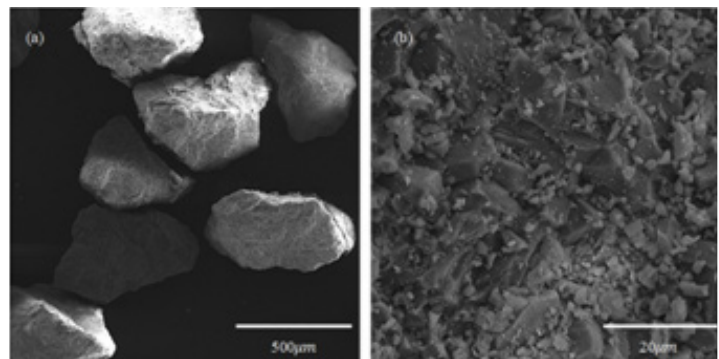
Fig. 1. SEM image of a) dolomite grains, b) raw dolomite surface.